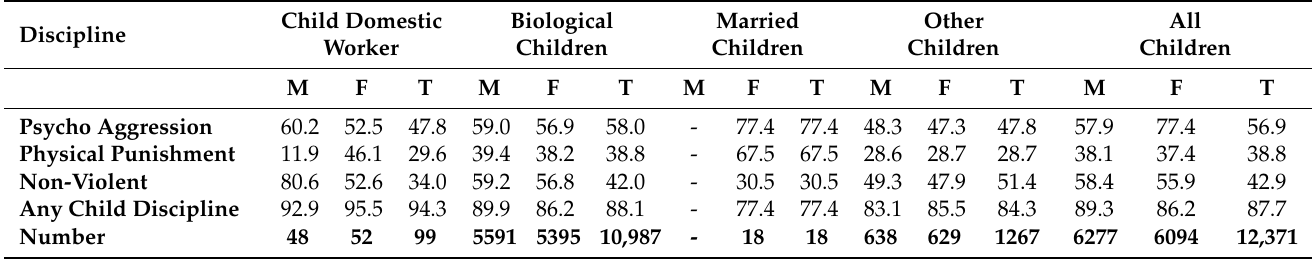
Table 9. Proportion of children with Functional Difficulties by sex ( N = 15,023,